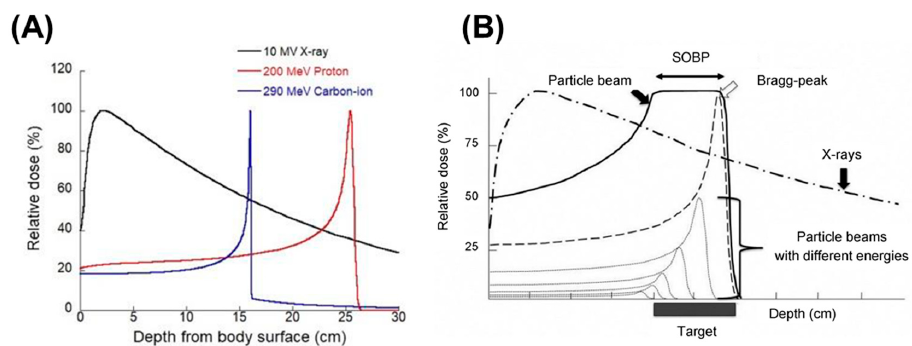
Figure 1. ( A ) Depth-dose distributions of clinical X-ray, proton, and carbon-ion beams, and ( B ) the spread-out Bragg peak (SOBP). Reproduced from [5], with permission from Elsevier, Copyright 2021.